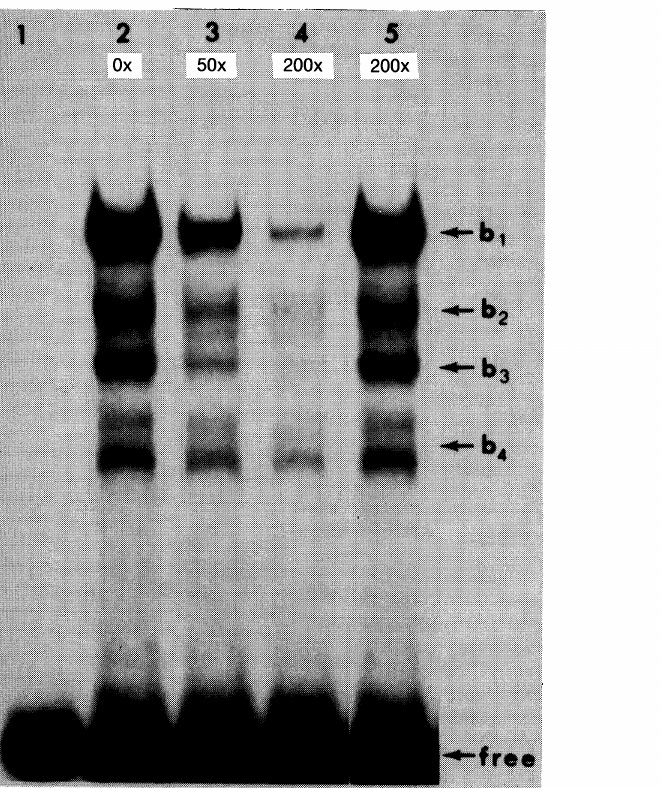
FIG. 5. DNA mobility shift binding profile. The ACC promoter II fragment spanning from -389 to -359 was end labelled and used for the binding assays as described in Materials and Methods. The nuclear extracts from differentiated 30A5 cells (D+4) were added to the binding reactions. The molar excess of unlabelled competitor DNA in the binding mixtures is indicated above each lane. Lane 1, the 32p labelled DNA probe; lanes 2 to 5, the labelled 30-mer probe DNA in the presence of 30A5 nuclear extracts; lanes 3 and 4, in the presence of different amounts of the same unlabelled 30-mer; lane 5, in the presence of a nonspecific sequence (30-mer) of the ACC promoter fragment spanning from 291 to 207.